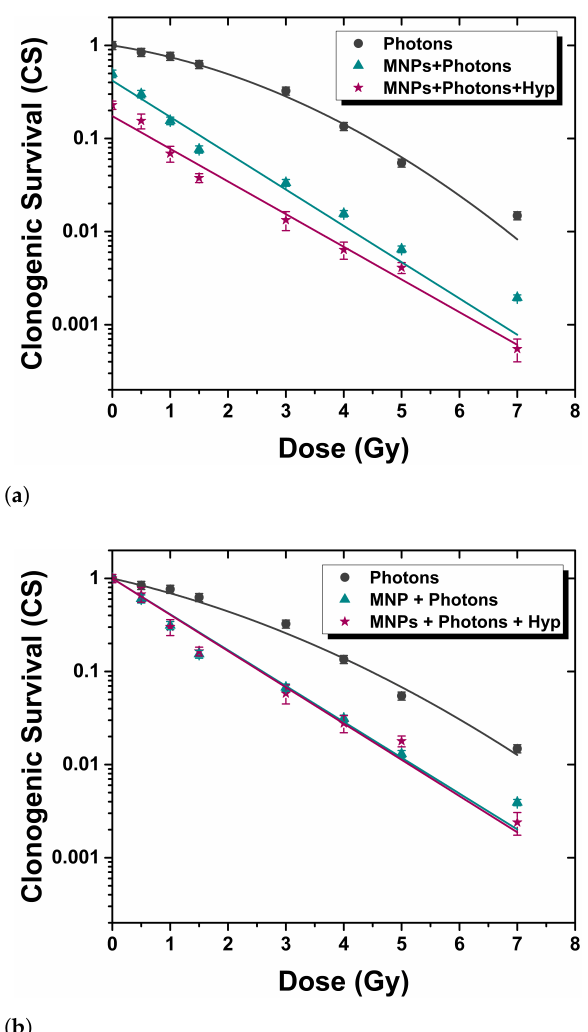
Figure 3. Clonogenic survival of BxPC3 cells culture for three different protocols (see text): photon therapy only (gray squares, Mode 1 ), photon therapy+MNPs administration (teal triangles, Mode 2 ) and photon therapy+MNPs administration+Hyp (plum stars, Mode 3 ). ( a ) not normalized curves; ( b ) normalized